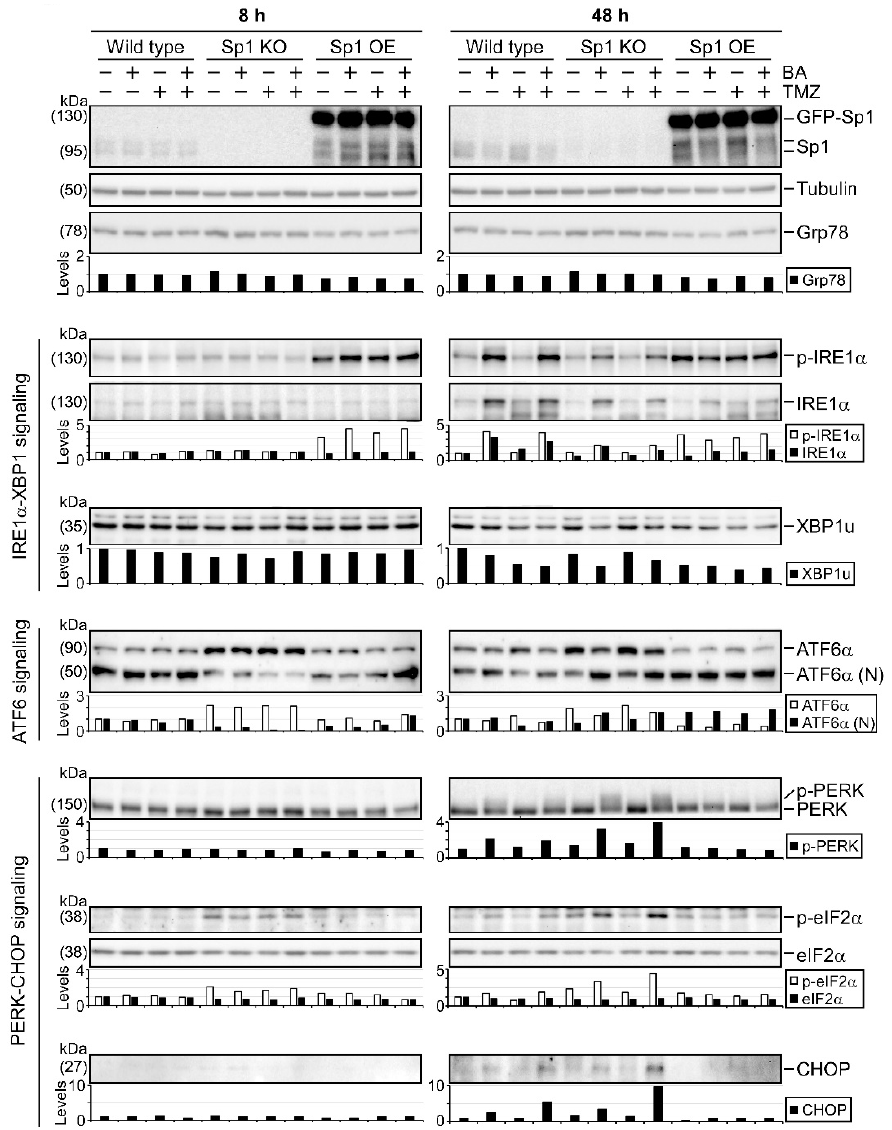
Figure 5. Roles of Sp1 in regulating UPR signaling. Wild-type, Sp1-knockout, and GFP-Sp1-overexpressing U87MG cells collected 8 h or 2 days after treatment with BA (20 µ M) and / or TMZ (100 µ M). Cellular lysates then analyzed by Western blotting with indicated antibodies. For more details of Western blot, please view Supplementary